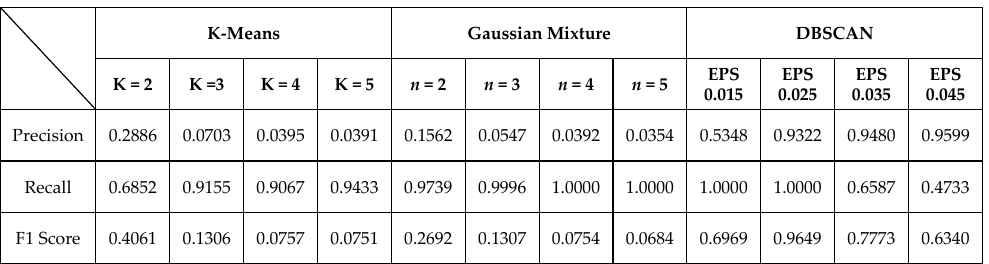
Table 1. Statistical analysis of the clustering algorithms. Algorithm performance is expressed as precision, recall, and F1 Score.